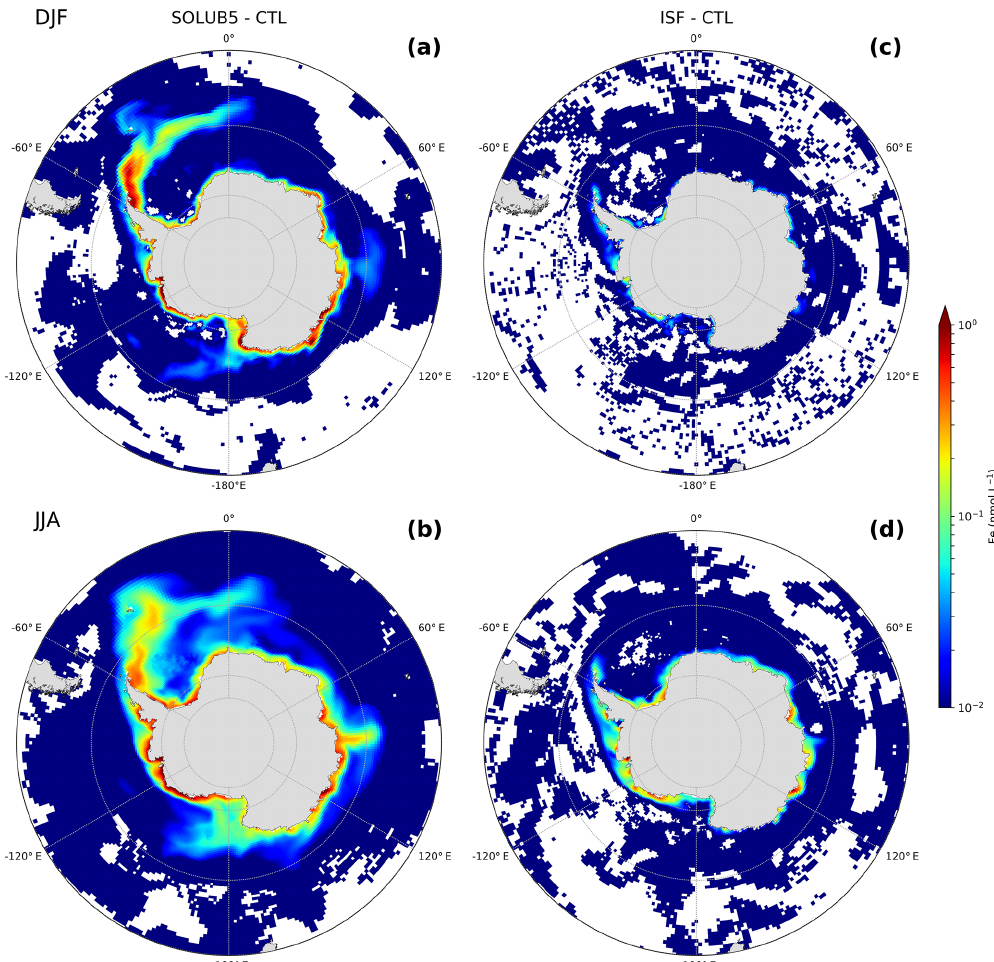
Figure 7. Difference in surface Fe concentrations between the (a, b) SOLUB5 and (c, d) ISF experiments and the CTL experiment (exper- iments minus CTL) in (a, c) summer (December, January, and February) and (b, d) winter (June, July, and August) in the Southern Ocean, south of 45 ◦ S. White areas are regions with nonsignificant changes. Note the logarithmic